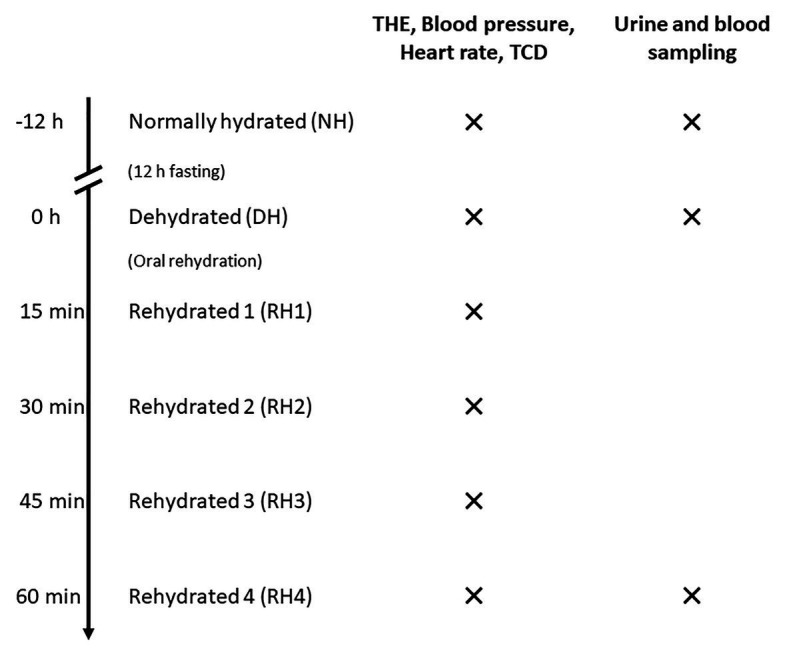
Time sequence of THE examinations in volunteers. Volunteers were first examined in a normally hydrated state (NH). After a 12-h-fasting period, measurements were conducted in the dehydrated state (DH). Then, four sets of data in different hydration states were acquired after oral rehydration (RH1–RH4) at 15-min intervals. For every hydration state, time-harmonic elastography (THE), transcranial Doppler (TCD), and blood pressure and heart rate measurements were performed. Urine and blood for determination of urine osmolality and hematocrit were sampled at hydration states NH, DH, and RH4.